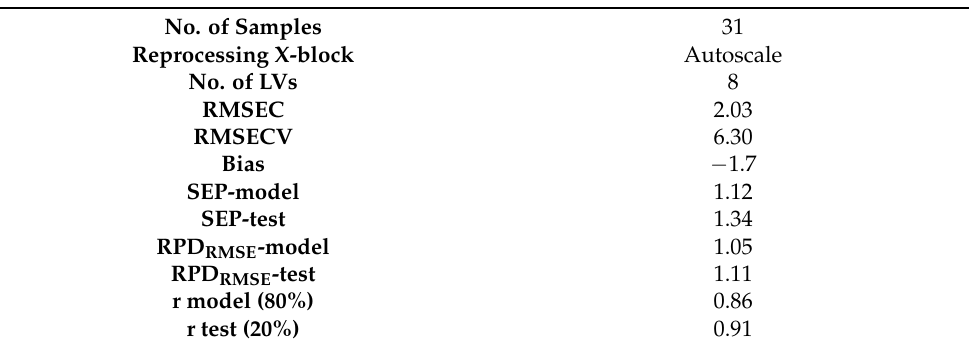
Table 6. Characteristics and principal results of the partial least squares regression model to pre- dict the irrigation water input. LVs, latent vectors; RMSEC, root-mean-square error of calibration; RMSECV, root-mean-square error of cross-validation.